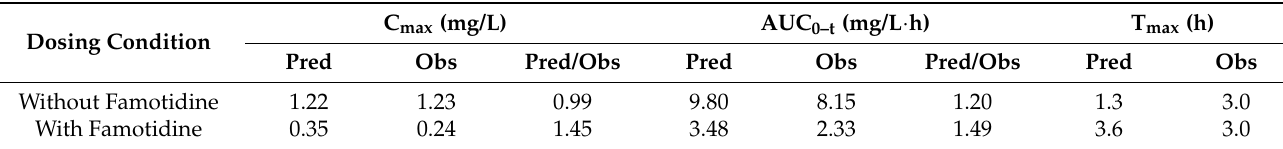
Figure 5. Simulated (Mean, 5th and 95th Percentiles) and Observed (Mean + SD) plasma concentration time profiles of the model compound following oral administration of 150 mg of the free form under fasted conditions: ( A ) without famotidine and ( B ) with famotidine, as reported by Gesenberg et al. [8]. Table 4. Simulated and Observed PK parameters (arithmetic means) of the model compound following administration of 150 mg of the free form under fasted condition without and with famotidine co-dosing. C max (mg/L) AUC 0–t (mg/L · h) T max (h) Dosing Condition Without Famotidine